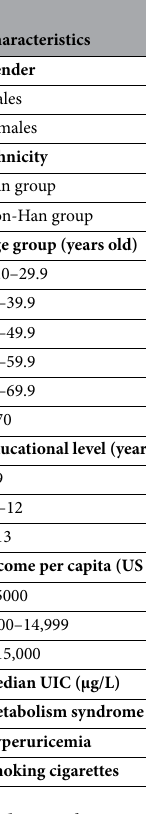
Table 1. Characteristics of the total study participants by